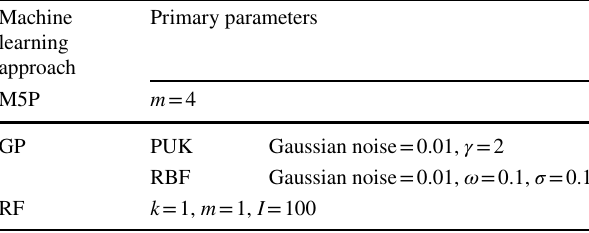
Primary parameters